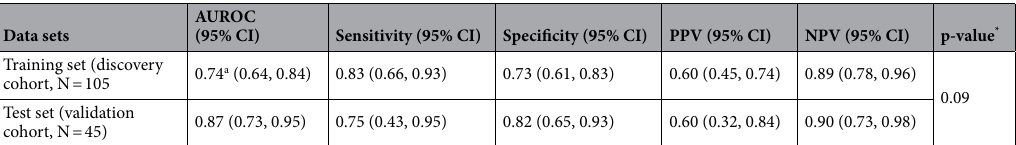
Table 3. The performance of the integrated radiomic-clinical classification model to distinguish TMB-high from TMB-low ECs. TMB tumor mutational burden, EC endometrial cancer, AUROC Area under the receiver operating curve, CI confidence interval, PPV positive predictive value, NPV negative predictive value. *deLong test. a Cross-validated